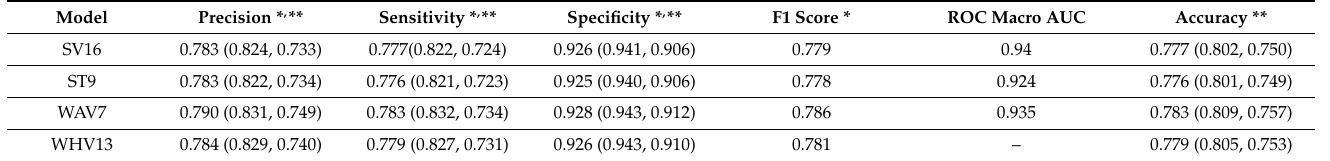
Table 8. Evaluation metrics for the models with the highest accuracy by pruning in each of the four ensemble learning methods. SV16: top16 was used for soft voting, ST9: top9 was used for stacking, WAV7: top7 was used for weighted average voting, WHV13: top13 was used for weighted hard voting.